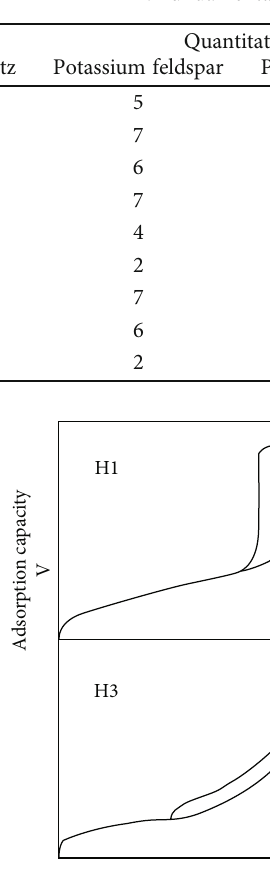
Table 1: Fundamental analysis data of shale samples.